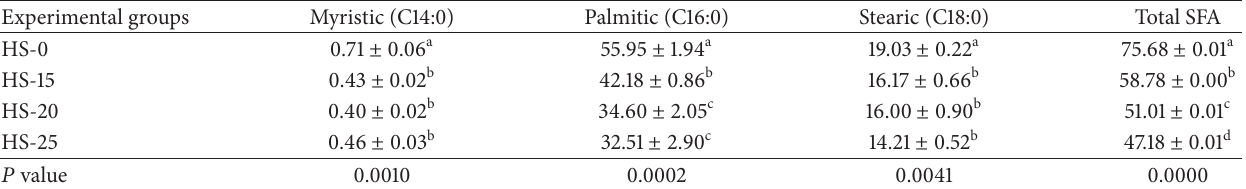
Table 3: Mean ± SE of saturated fatty acid (mg/g) in eggs from hens fed with different levels of hemp seed ( 𝑛 = 3 ).